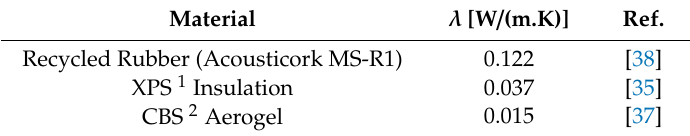
Table 3. Thermal conductivities ( λ ) of thermal break strips (10.0 mm thick).